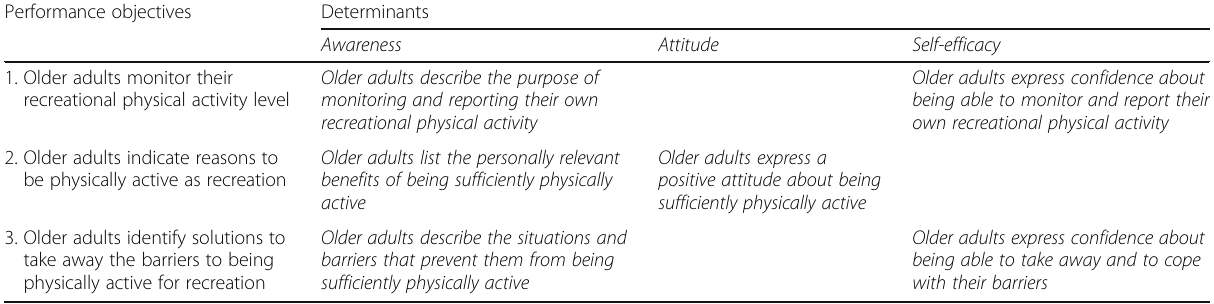
Table 1 Sample change objectives (combination of performance objectives and determinants) for promoting recreational physical in the over-fifties, the Active plus program (van Stralen et al., 2008) Performance